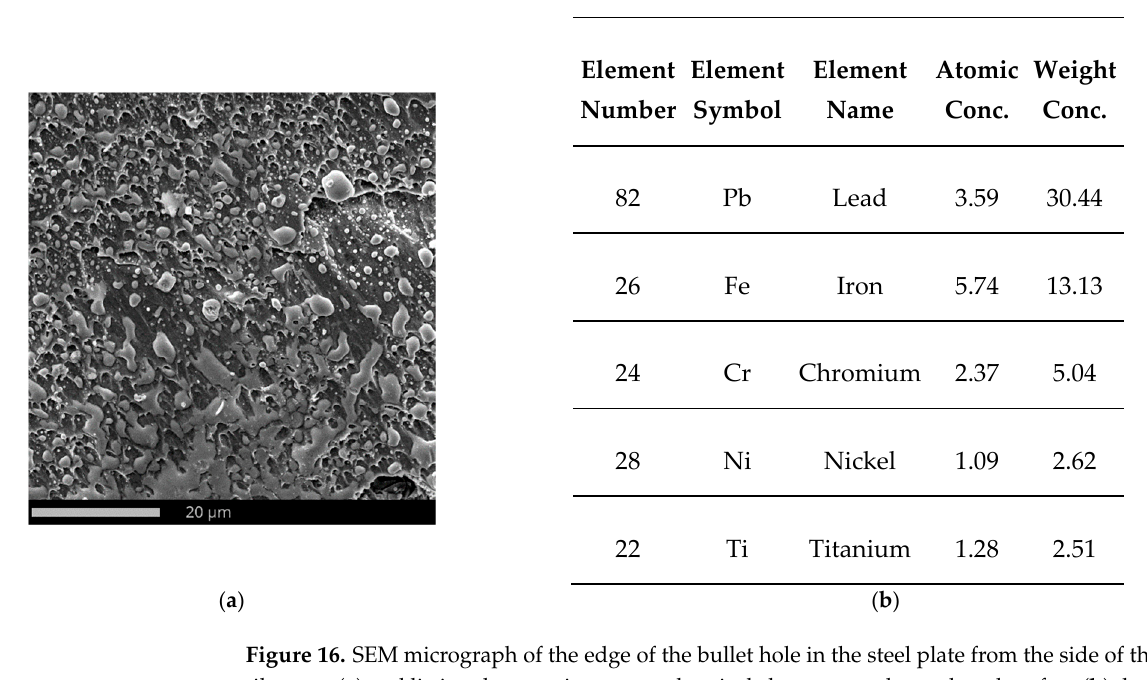
determined by SEM ‐ EDS (FOV: 86.6 μ m, Mode: 15 kV—Image, Detector: